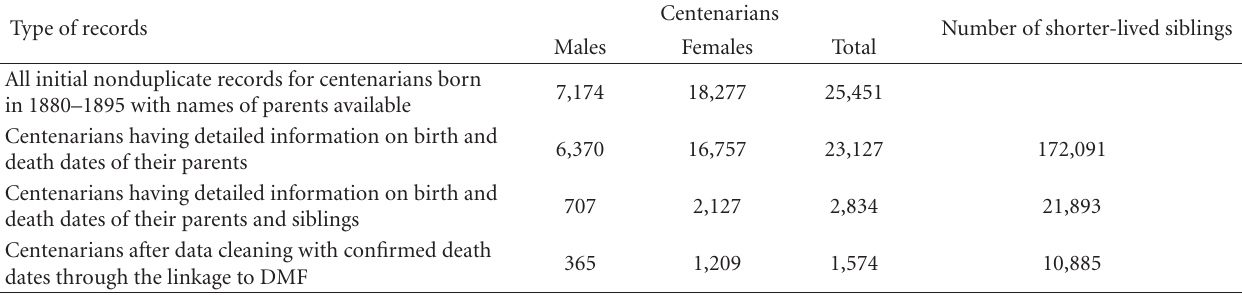
Table 1: Number of centenarians and their siblings at di ff erent stages of data collection and cleaning. Type of records